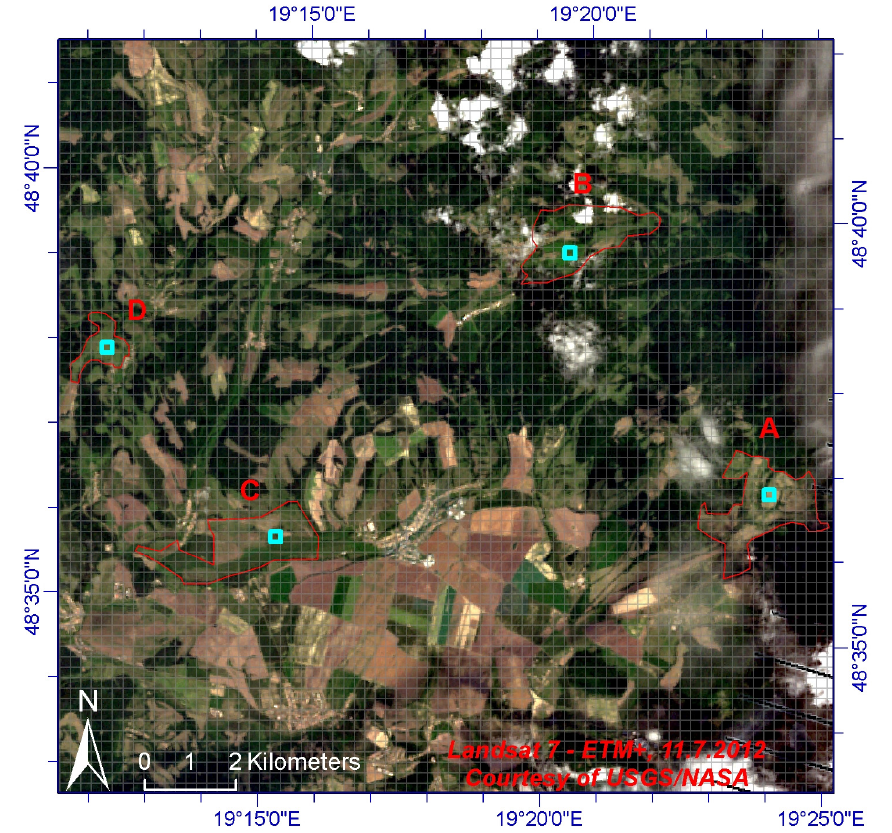
Figure 3. Selection of MODIS homogenous pixels for